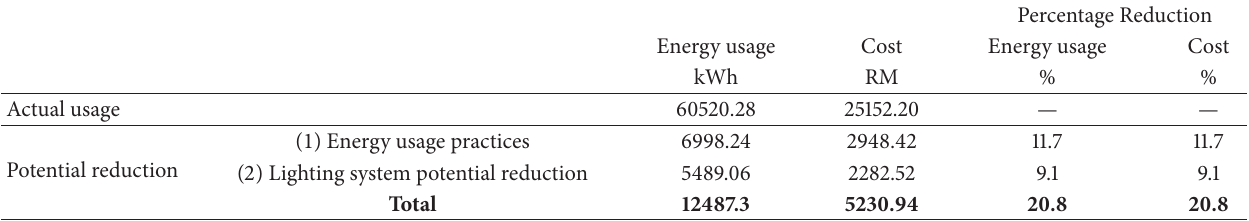
Table 13: Potential energy reduction and cost savings from energy conservation measures.